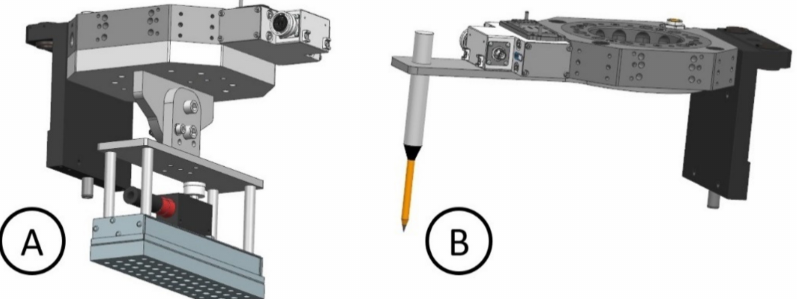
Figure 11. This figure shows two tools used by the IRB 6700 in the surface inspection. ( A ) Shows the vacuum gripper and ( B ) shows the pen tool.